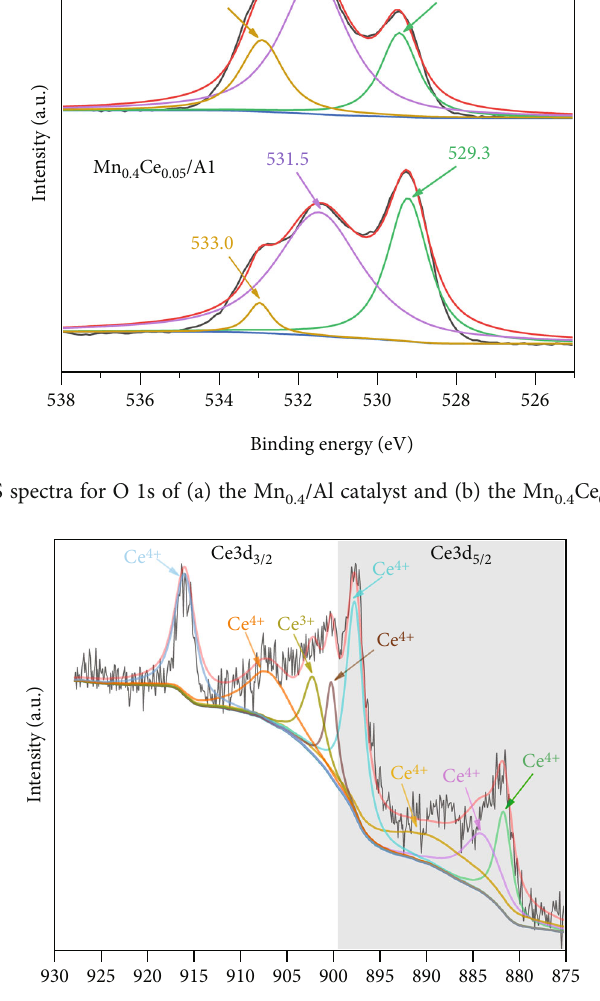
Figure 6: XPS spectra for Ce 3d of the Mn Table 1: Results of the XPS results of Mn